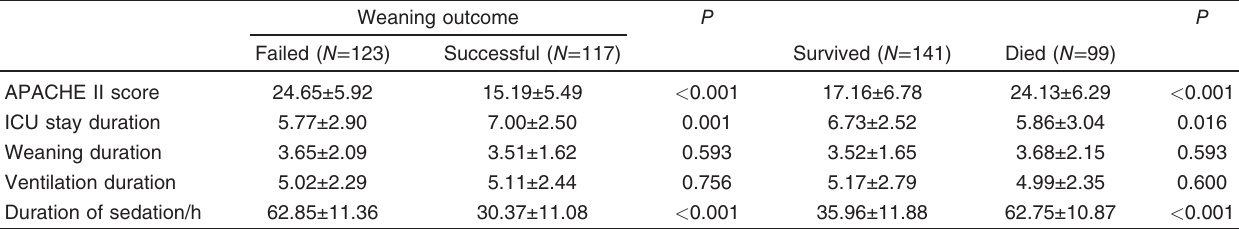
Table 2 Relation of Acute Physiology and Chronic Health Evaluation II score, ICU stay duration, weaning duration, ventilation duration, and duration of using sedation per hour to weaning outcome Weaning